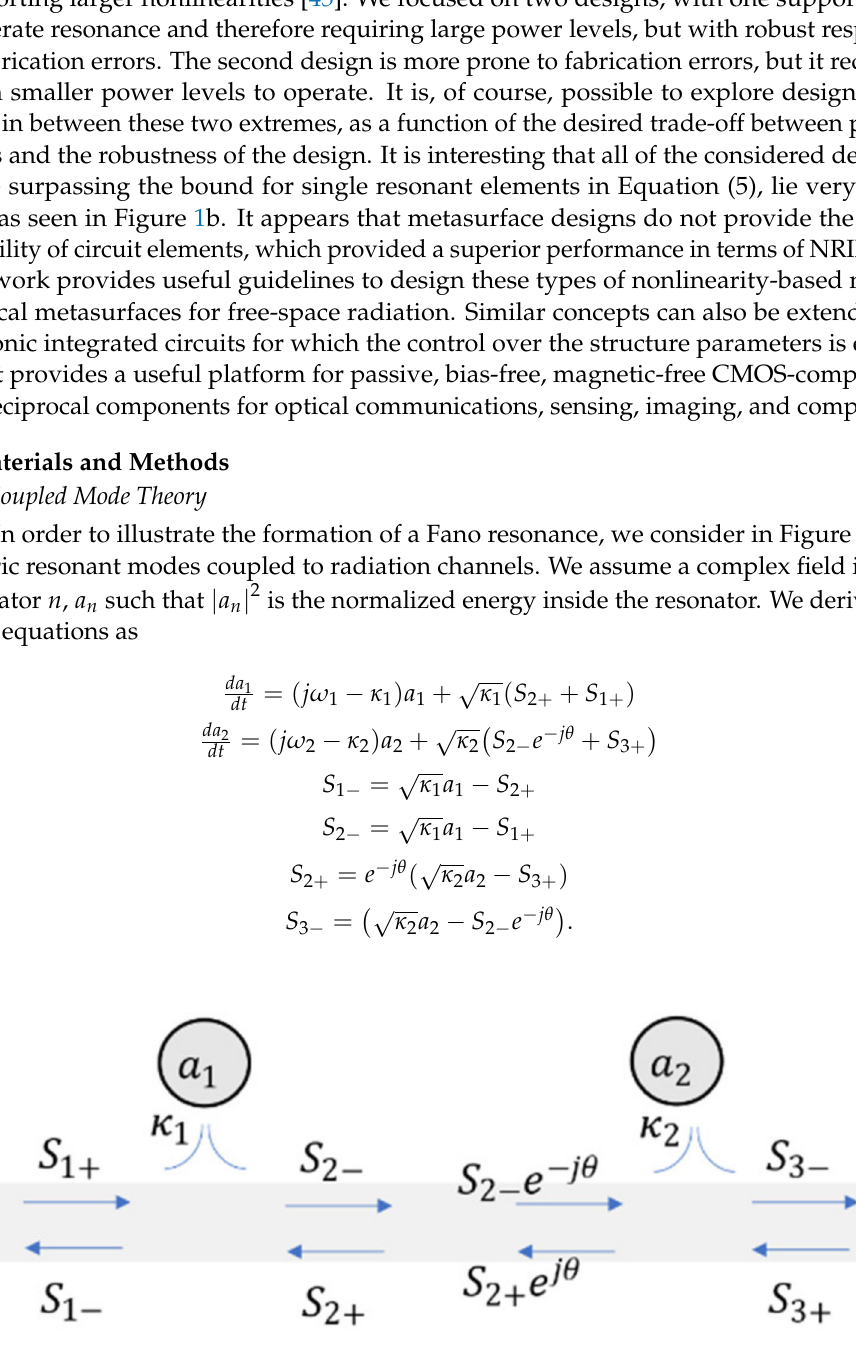
Figure 9. Schematic model of coupled resonators to and from a Fano